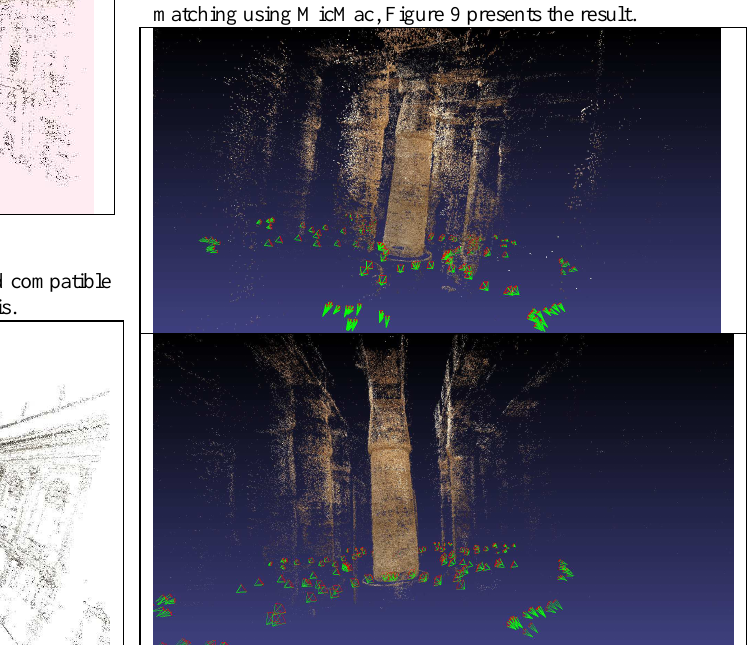
Figure 8. Result of orientation on the Karnak